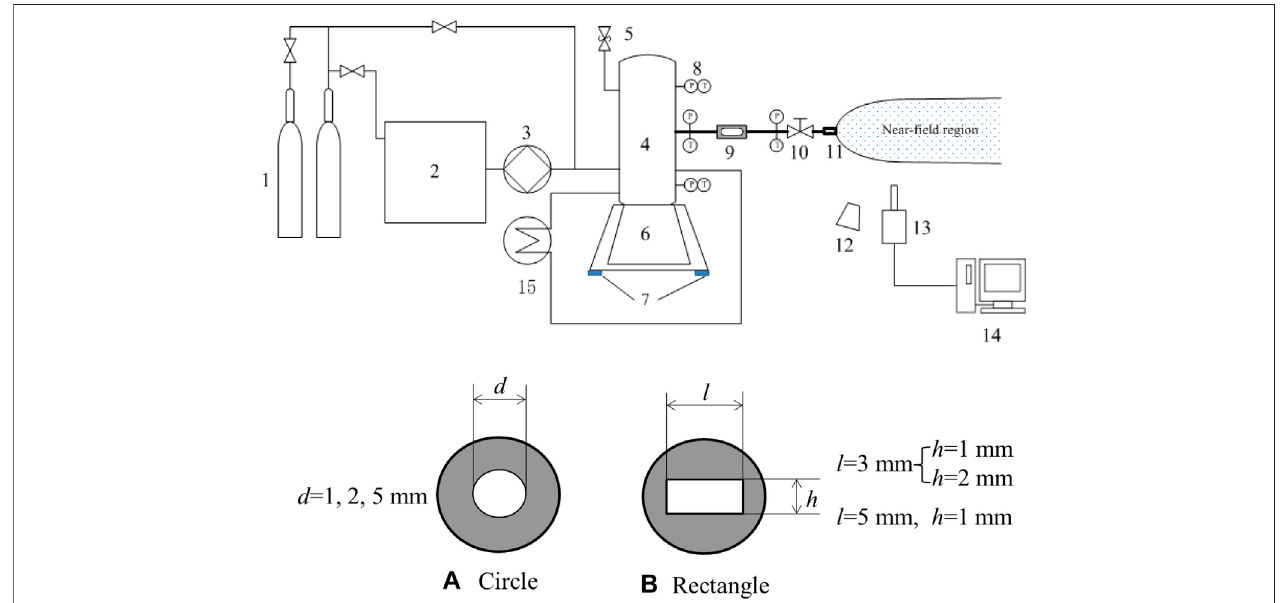
FIGURE3| Schematicoftheexperimentalsetup.1 — CO 2 gasbottle,2 — Hermeticallysealedrefrigeratingunit,3 — CO 2 cryopump,4 — Superhighpressurevessel, 5 — Safety valve, 6 — Stainless steel base, 7 — Load cells, 8 — Pressure and temperature sensors, 9 — Observation window, 10 — Normally closed pneumatic valve, 11 — Stainlesssteelnozzle,12 — Photo fl oodlamp, 13-High-speedcamera (FastcamSA-X2,Photron Ltd.), 14 — Dataacquisitionsystem,15 — Thermostatic